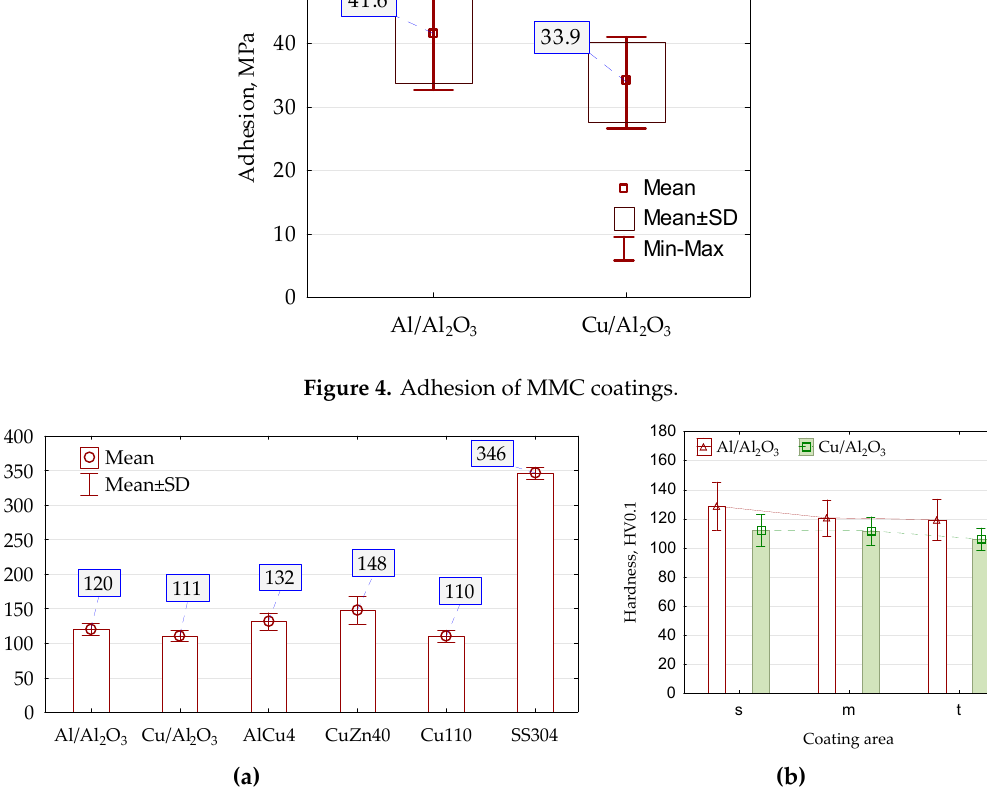
Figure 4. Adhesion of MMC coatings.